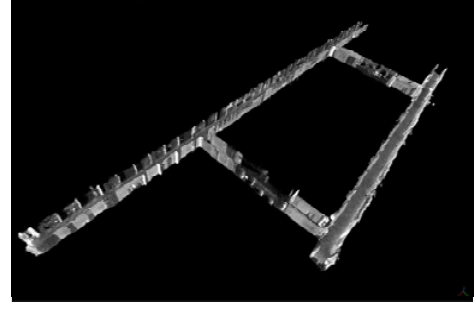
Figure 7. Generated 3D map